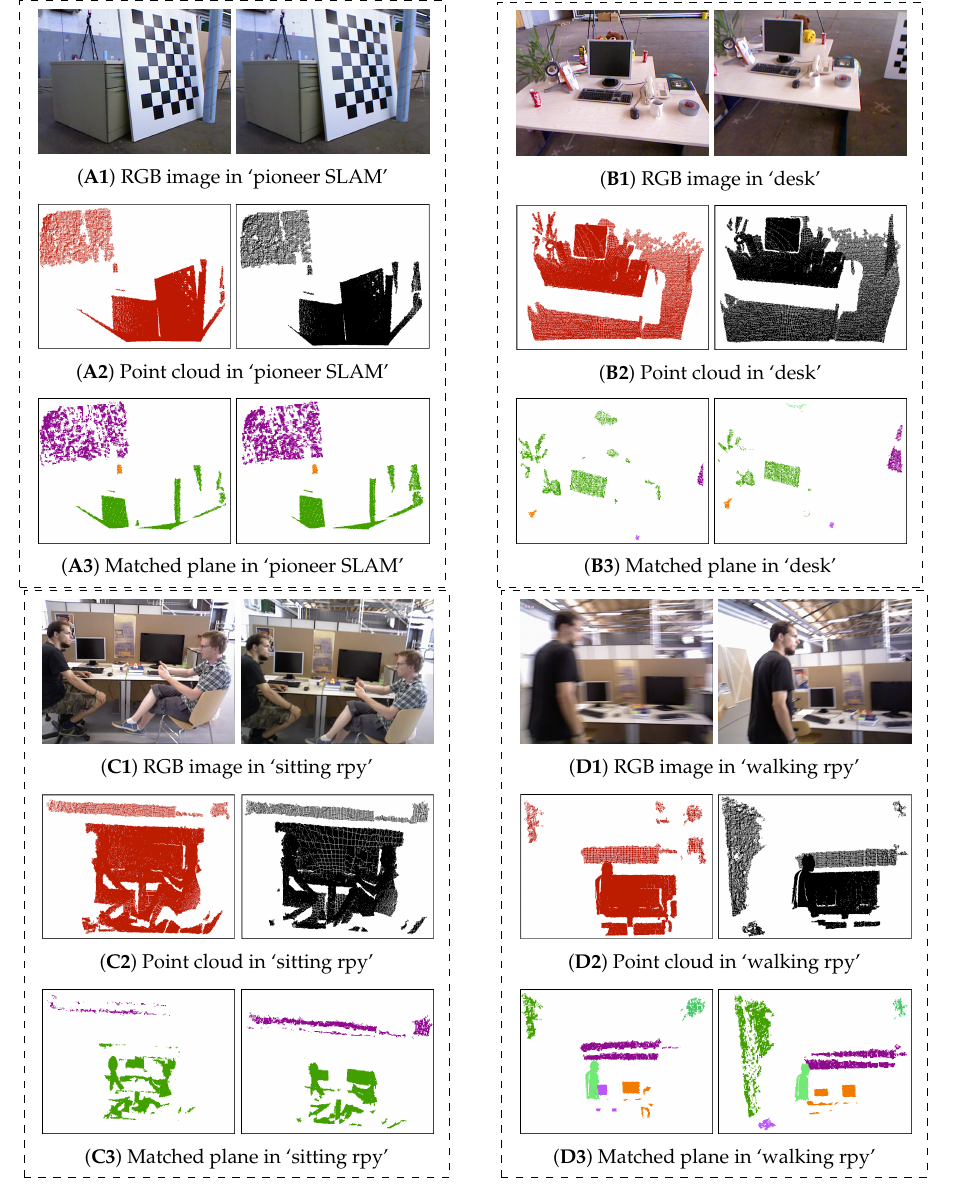
Figure 3. Demonstration of the result of the PCPM algorithms of four sequences: 1st row, ‘pioneer SLAM’ and ‘desk’; 2nd row, ‘sitting rpy’ and ‘walking rpy’; ( A1 – D1 ) the RGB image in four sequences; ( A2 – D2 ) the point cloud in four sequences; ( A3 – D3 ) the matched planes in four